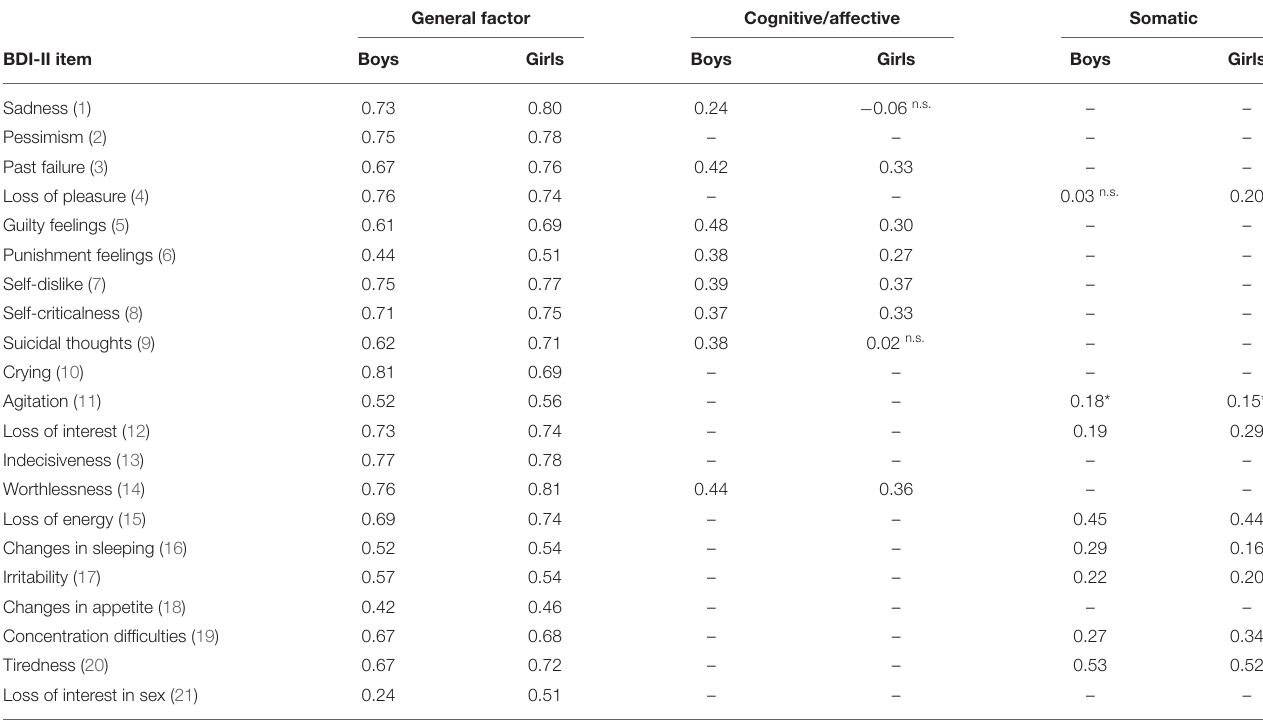
TABLE 6 | Factor loadings for the confirmatory bifactor solution for boys ( n = 345) and girls ( n = 490). General factor Cognitive/affective Somatic